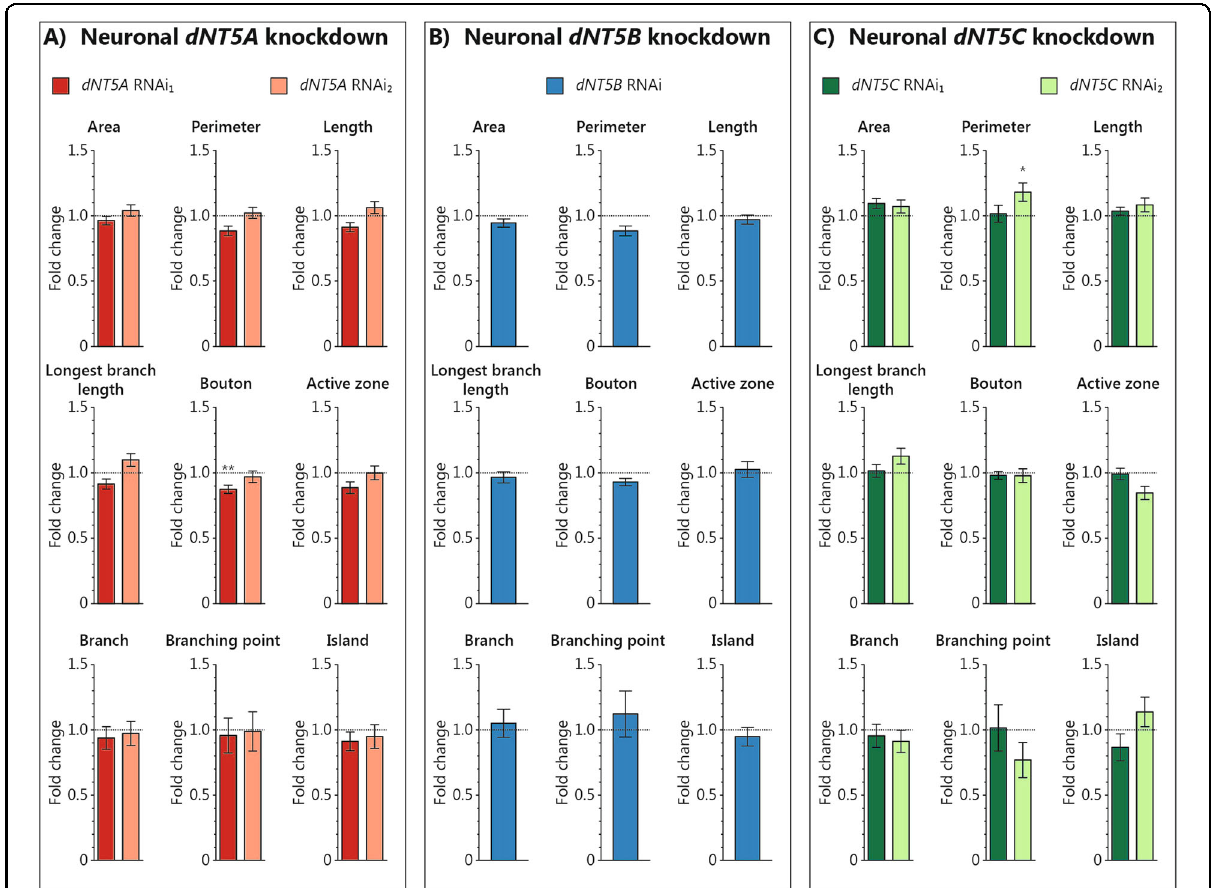
Fig. 4 Neuronal manipulation of dNT5A , dNT5B , and dNT5C did not affect development of synaptic terminals at the Drosophila neuromuscular junction (NMJ). A – C Synaptic NMJ parameters of pan-neuronal manipulation of A dNT5A (RNAi 1 : w , UAS - Dcr2 ;; nSyb - Gal4 / UAS - dNT5A RNAi 1 , n = 34; RNAi 2 : w , UAS - Dcr2 ; UAS - dNT5A RNAi 2 ; nSyb - Gal4 , n = 33), B dNT5B ( w , UAS - Dcr2 ;; nSyb - Gal4 / UAS - dNT5B RNAi , n = 29), and C dNT5C (RNAi 1 : w , UAS - Dcr2 ;; nSyb - Gal4 / UAS - dNT5C RNAi 1 , n = 15; RNAi 2 : w , UAS - Dcr2 ; UAS - dNT5C RNAi 2 ; nSyb - Gal4 , n = 26). All values were normalized to respective control ( dNT5A , dNT5B , and dNT5C RNAi 1 : w , UAS - Dcr2 ;; nSyb - Gal4 / + , n = 36; dNT5A and dNT5C RNAi 2 : w , UAS - Dcr2 ; + ; nSyb - Gal4 , n = 40). Representative NMJ terminal microscope images are presented in Supplementary Fig. 3. Error bars represent standard error of the mean. One-way analysis of variance (ANOVA) followed by Dunnett ’ s post-hoc test was used to obtain an adjusted p -value ( p adj ). (* p adj < 0.05, ** p adj < 0.01, *** p adj < 0.001). N = 5 – 10